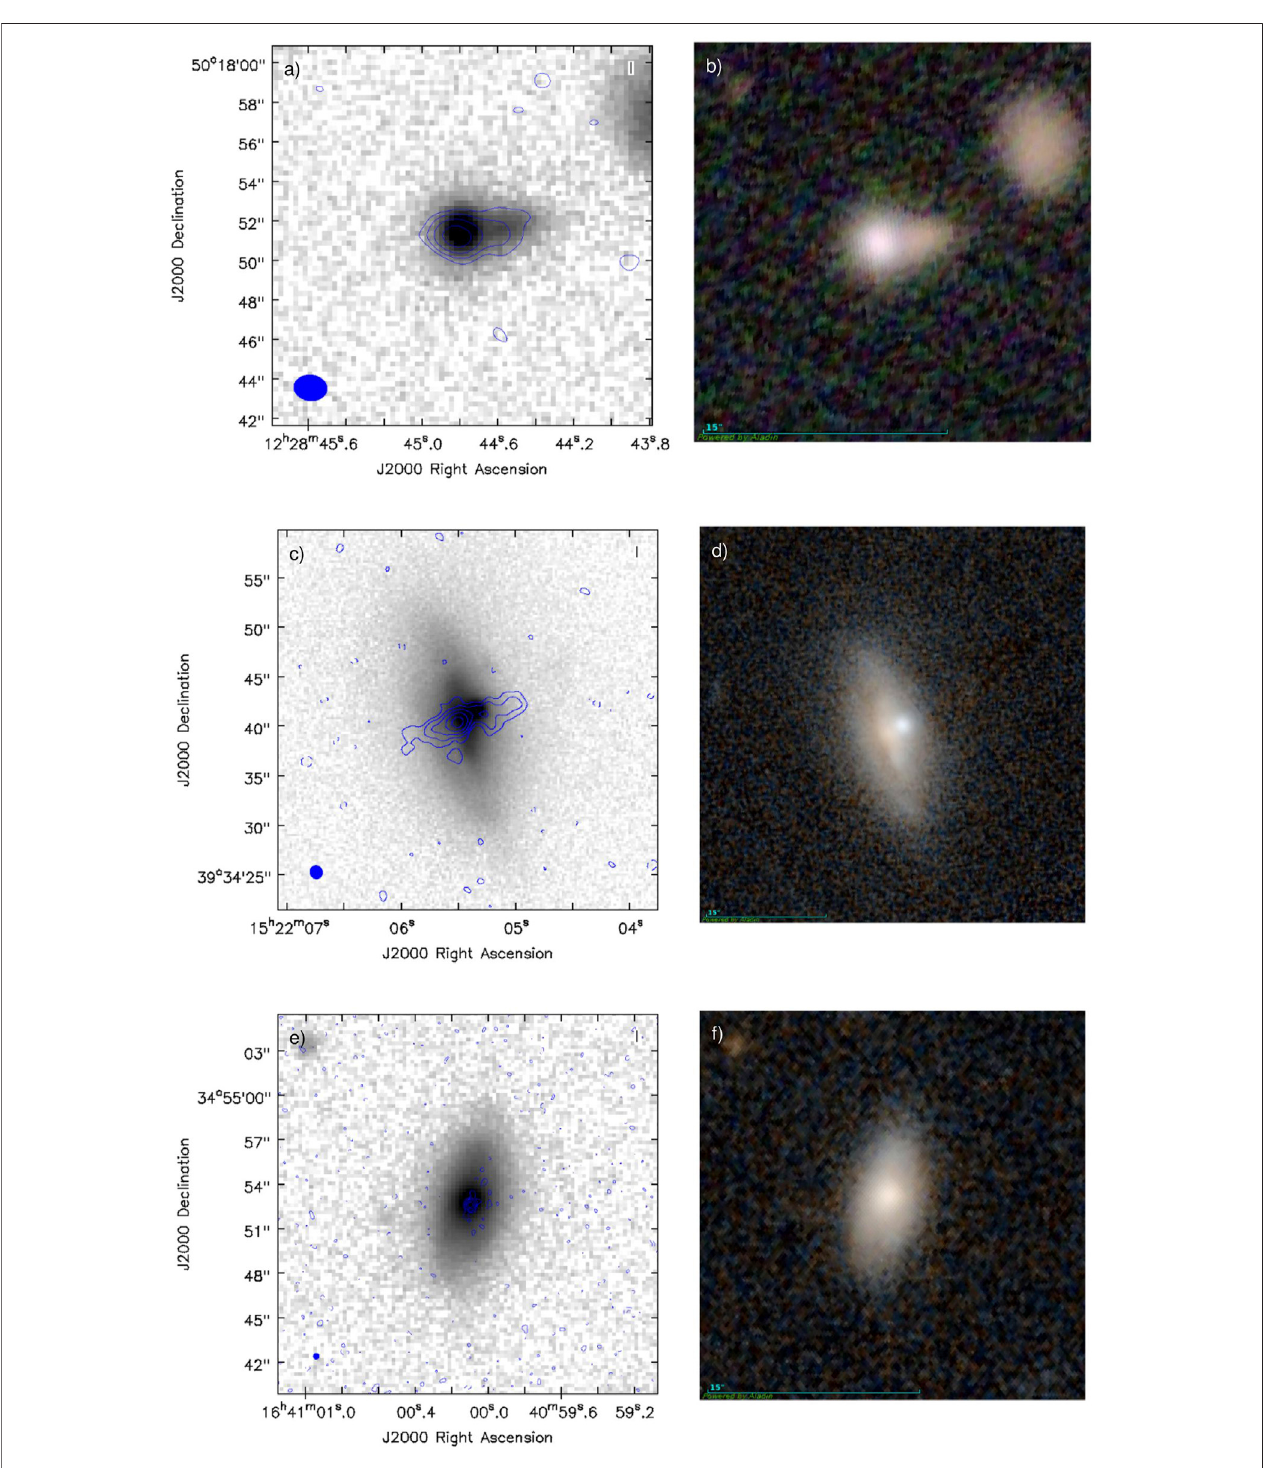
FIGURE 4 | (A) J1228 + 5017 1.6 GHz radio map overlaid with the i -band Pan-STARRS image; (B) J1228 + 5017 Pan-STARRS i - r - g colour image; (C) J1522 + 39341.6 GHzradiomapoverlaidwiththe i -bandPan-STARRSimage; (D) J1522+3934Pan-STARRS z - g colourimage; (E) J1641+34545.2 GHzradiomapoverlaid with the i -band Pan-STARRS image; (F) J1641 + 3454 Pan-STARRS z - g colour image.